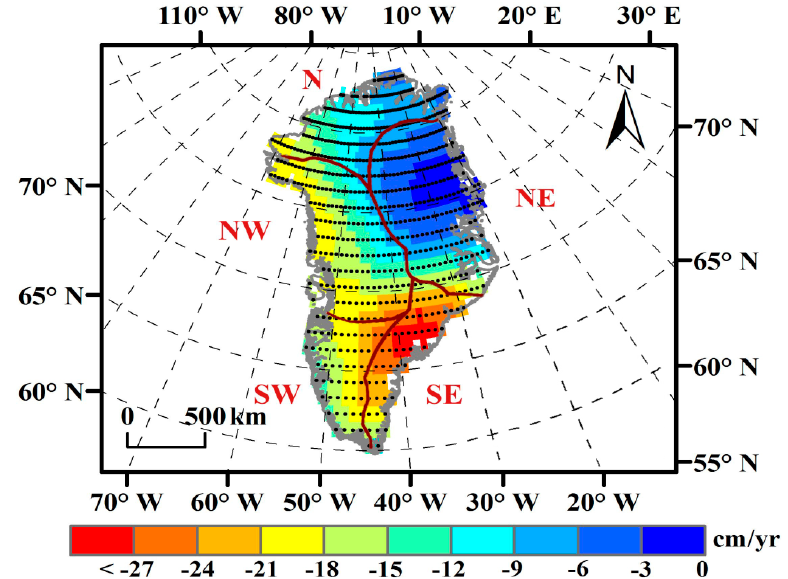
Figure 4. Spatial distribution of annual change trend of GRACE ice sheet mass in Greenland from 2003 to 2015. Note: Lattice point representation has passed the M–K test of 95% confidence interval.